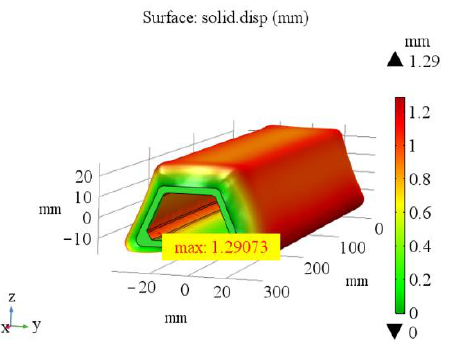
Figure 10. Thermal deformation of five bladders without considering uneven pressure. In order to accurately obtain the influence of different filling bladders on the uniformity of the skin-stringer thickness, the stiffened panel should be sectioned, and the thickness of the parts at different positions on the cross section on both sides of the section line should be measured and compared with the theoretical value to obtain the corresponding deviation, thus providing a reference for determining the best size and hardness of the stringer filling silicone rubber bladder. The deviation of thickness on different sections along the span direction at the same position (hat crown, hat web, skin) of single stringer is used as the representation indicator to measure the dimensional stability of the stringer manufactured by single bladder, and the comparison results of the dimensions obtained with different bladders are shown in Figures 12–16